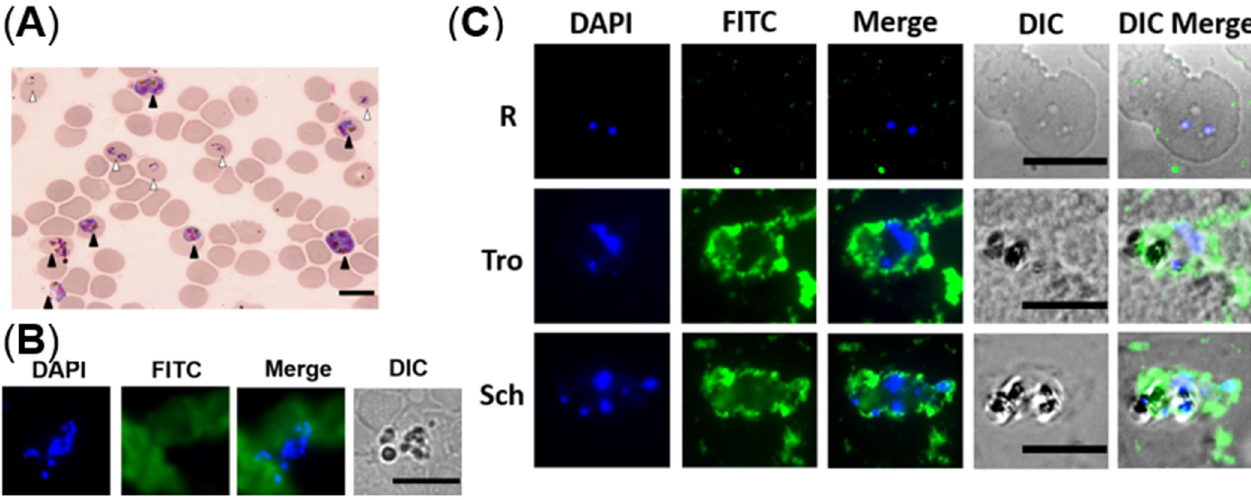
Figure 5. The distribution of NCDs in P. falciparum -infected erythrocytes. ( A ) Giemsa-stained thin blood smear of the non-synchronized culture revealed mixed developmental stages of iRBCs. White and black triangles indicate ring and schizont, respectively. ( B ) Fluorescent images of fixed iRBCs with NCDs. ( C ) Fluorescent images of live iRBCs at different stages with NCDs. DAPI was used for nuclear staining; NCDs were labeled with FITC; DIC (differential interference contrast): transmission light microscopy images of iRBCs. All scale bars: 10 µm.